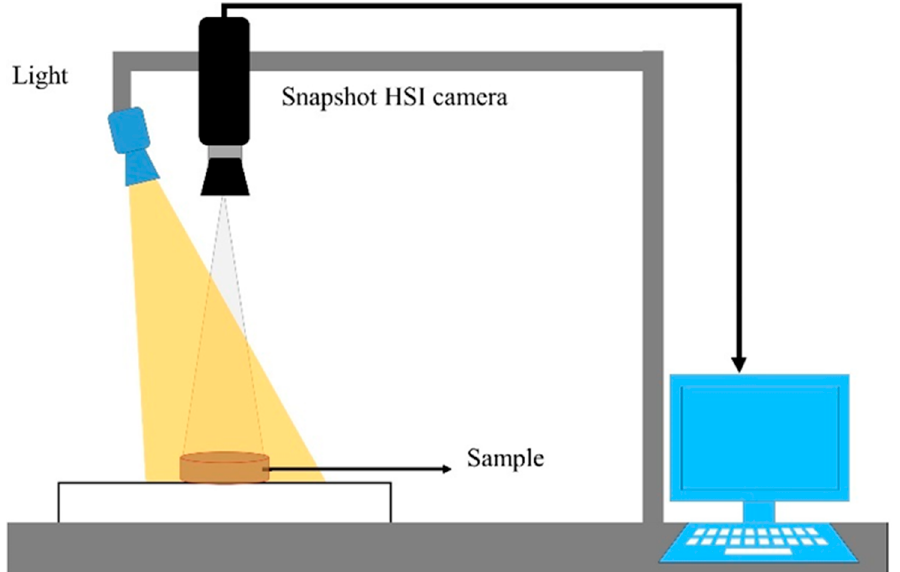
Figure 1. Demonstration of the implemented snapshot hyperspectral imaging (HSI) system.